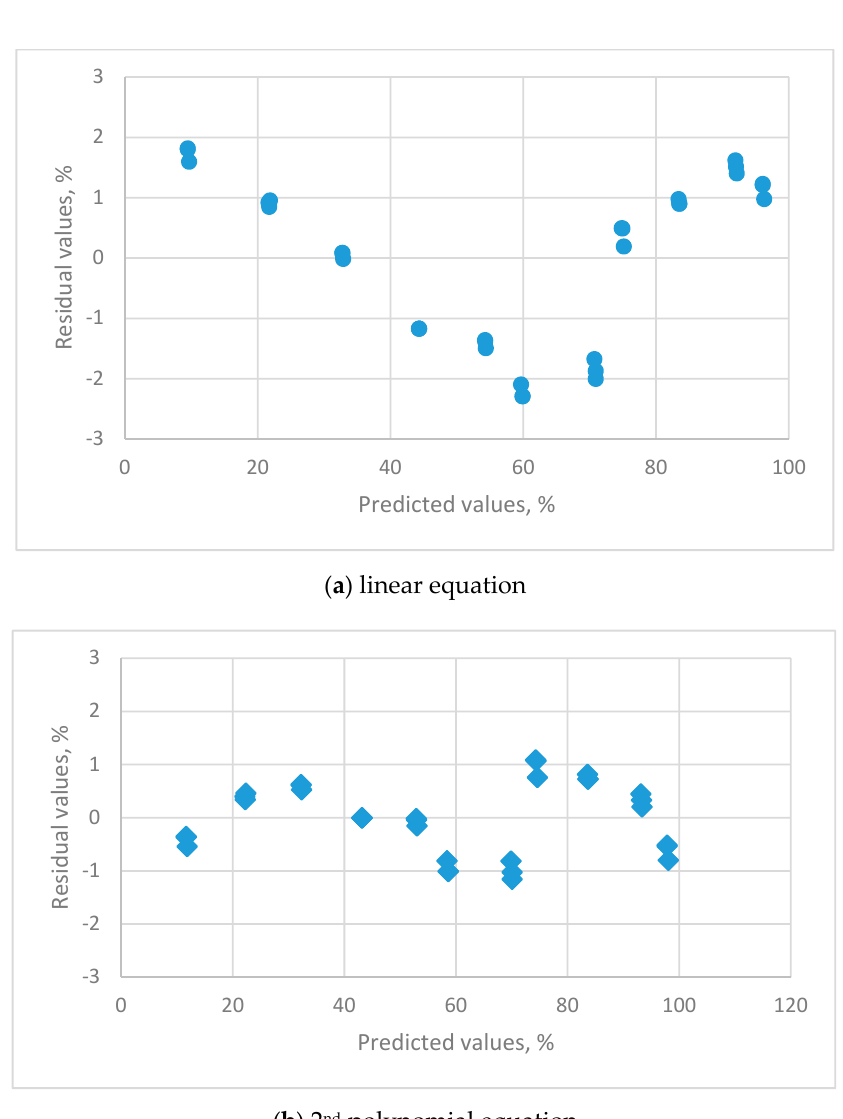
Figure 5. The residual plots for the calibration equations for different orders of polynomial equations for HMP 140A capacitance humidity sensor using 11 saturated salt solutions (LiCl, CH 3 COOK, MgCl 2 , K 2 CO 3 , Mg(NO 3 ) 2 , NaBr, KI, NaCl, KCl, KNO 3 and K 2 SO 4 ).